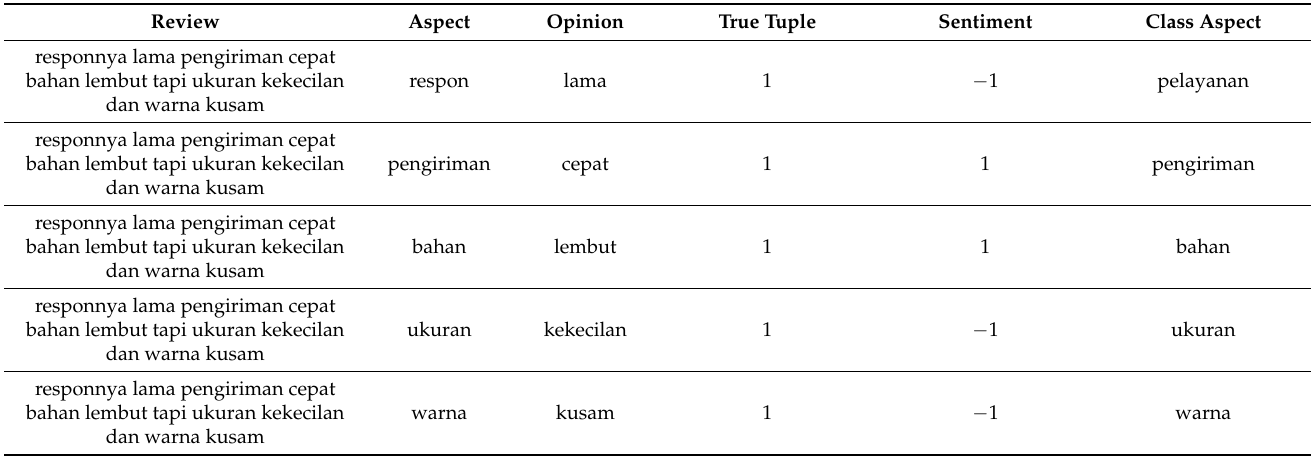
Table 2. An example of dependency parse result and labeled